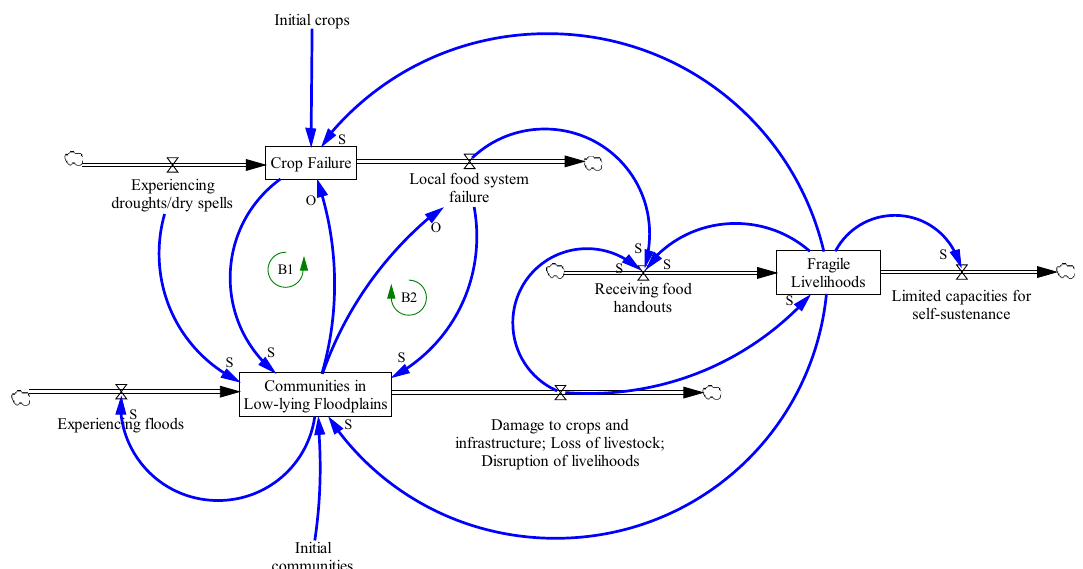
Fig. 3 Construction of vulnerability to floods and droughts in the northern semiarid tropics (SAT), Zimbabwe (B—balancing). Note The letters ‘‘S’’ and ‘‘O’’ at the arrowheads mean ‘‘support’’ and ‘‘oppose,’’